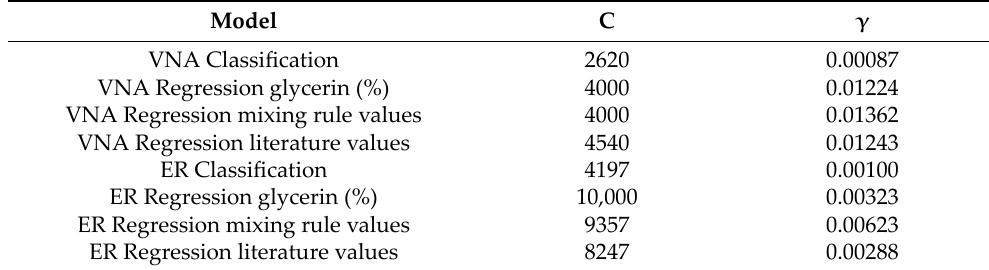
Table 2. ML models hyperparameters for the VNA and the electronic reader (ER).